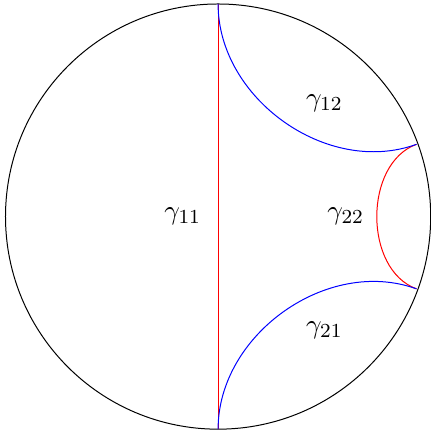
Figure 6 . The same geodesics as in figure 5 after applying an AdS 3 isometry to move the boundary- anchors γ 11 to the poles θ = 0 , π . This configuration allows us to compute changes in length by applying results from section